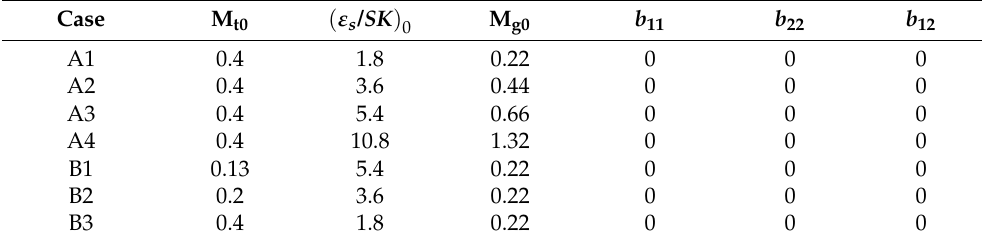
Table 3. Initial conditions for homogeneous shear flow: DNS [3]. Case M t0 ( ε s / SK )